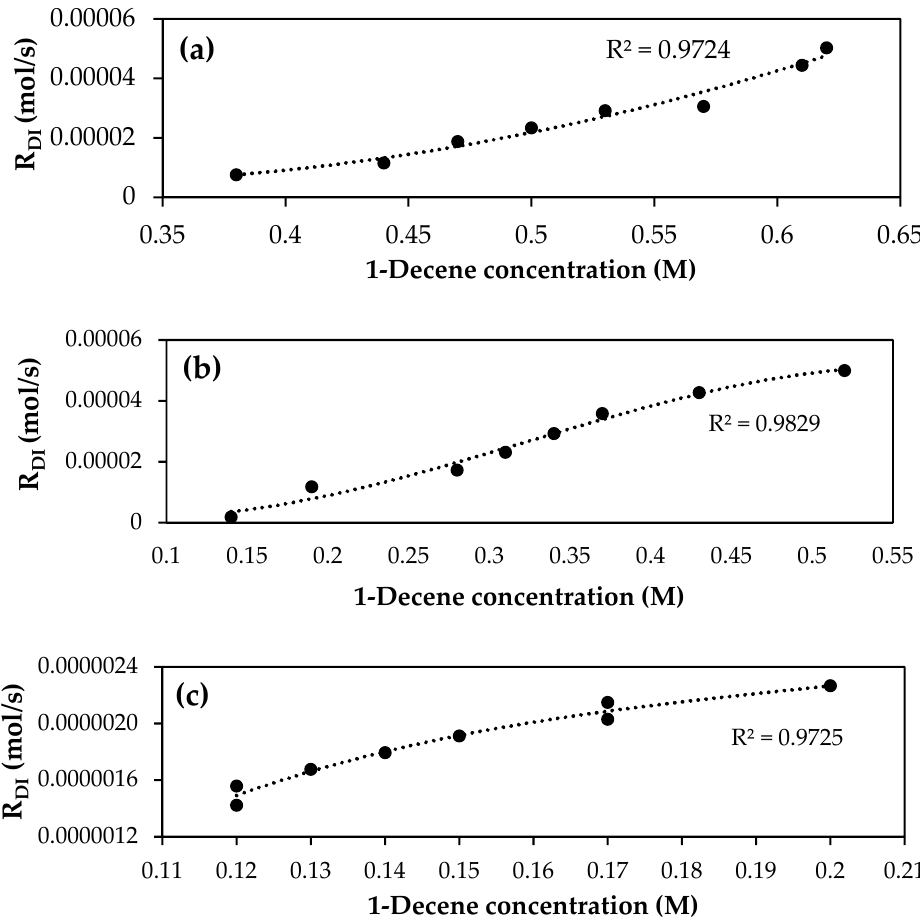
Figure 5. Parity curves of the reaction rate constants obtained from the experimental data and those calculated from the best fit equations for ( a ) the dimerization reaction and ( b ) the trimerization re- action .